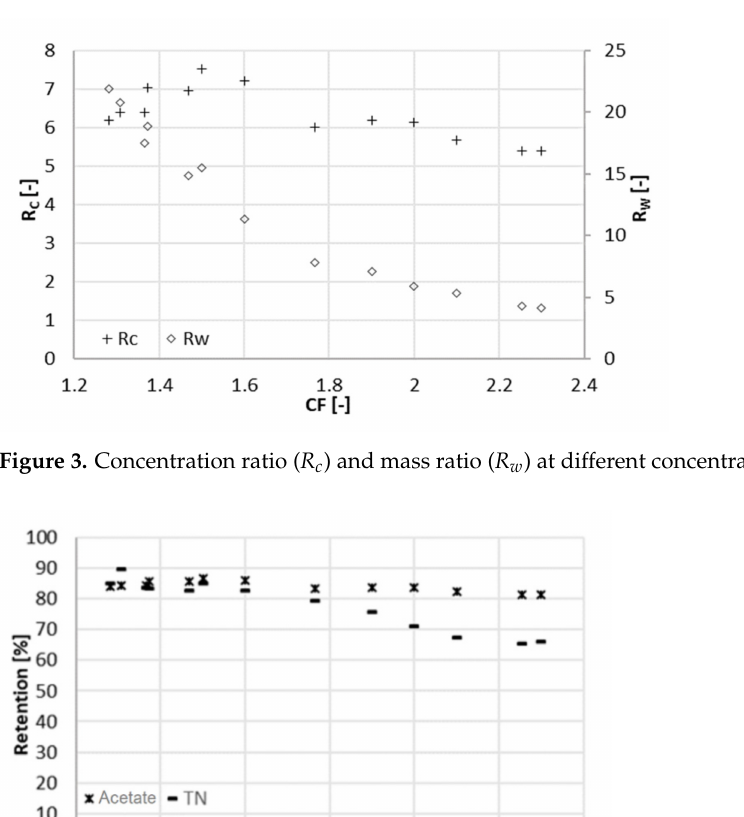
Figure 2. Osmotic pressure and acetate concentrations in the concentrate and in the permeate at different concentration factors CF (22 bar).